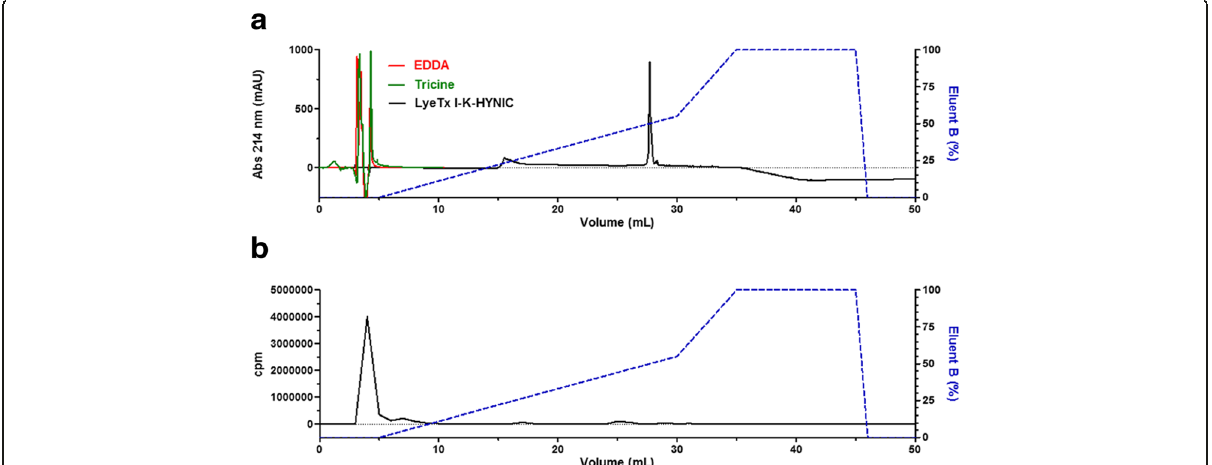
Fig. 4 LyeTx I-K-HYNIC- 99m Tc evaluation by RP-HPLC (717 Plus Autosampler, Waters, USA) associated with radioactivity determination of the collected fractions by automatic gamma counter (Wizard, Finland). a Chromatograms of EDDA ( red line ), tricine ( green line ) and LyeTx I-K-HYNIC ( black line ): ACE 5 C8 column (5 μ m, 250.0 mm × 4.6 mm) equilibrated with 0.1 % (v:v) TFA in water (eluent A) and eluted by a linear gradient of 0.1 % (v:v) TFA in acetonitrile (eluent B); the flow was 1.0 mL . min − 1 and the detection was at 214 nm. b Radiochromatogram of LyeTx I-K-HYNIC- 99m Tc: ACE 5 C8 column (5 μ m, 250.0 mm×4.6 mm) equilibrated with 0.1 % (v:v) TFA in water (eluent A) and eluted by a linear gradient of 0.1 % (v:v) TFA in acetonitrile (eluent B); the flow was 1.0 mL . min − 1 . cpm: counts per